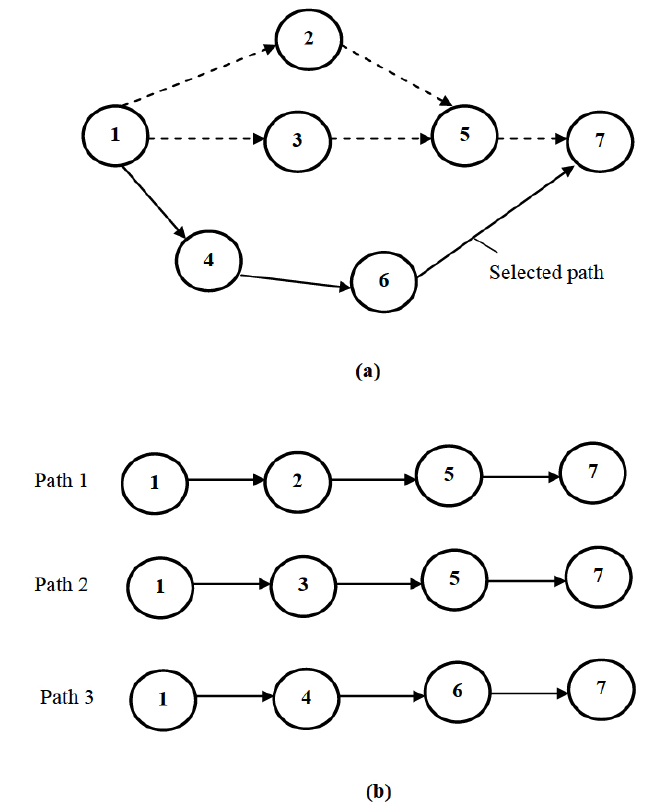
Figure 1. Example for path selection: ( a ) node arrangement ( b ) path possibilities between the source and